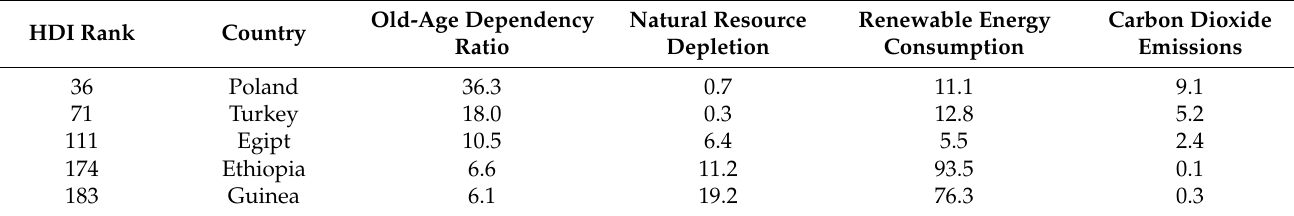
Table 1. Independent and Dependent